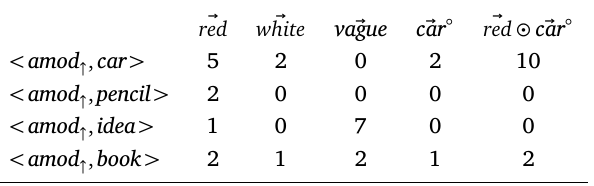
Deriving the vector of run in horses run by dependency-based compositionality (head